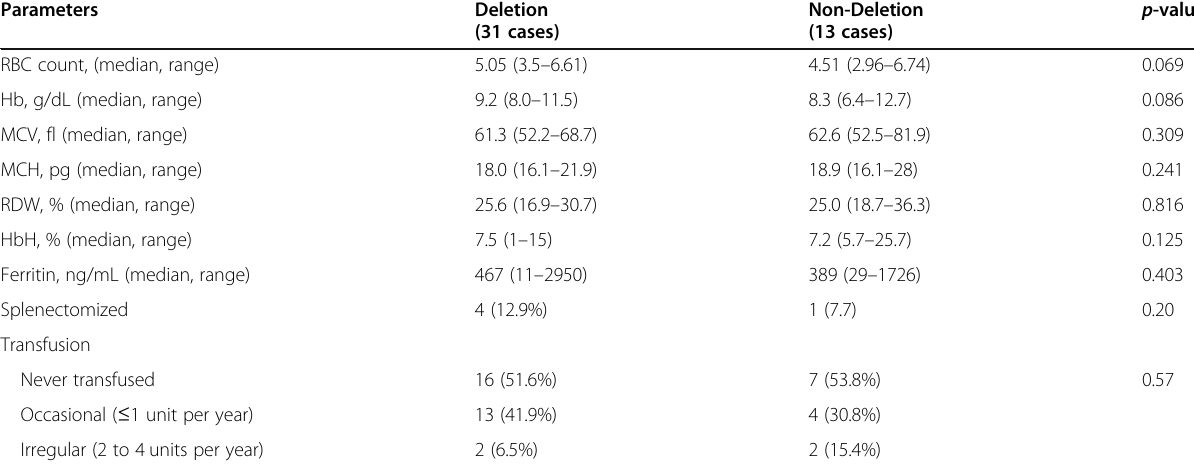
Table 4 Clinical and haematological parameters in the deletion and non-deletion types HbH Disease